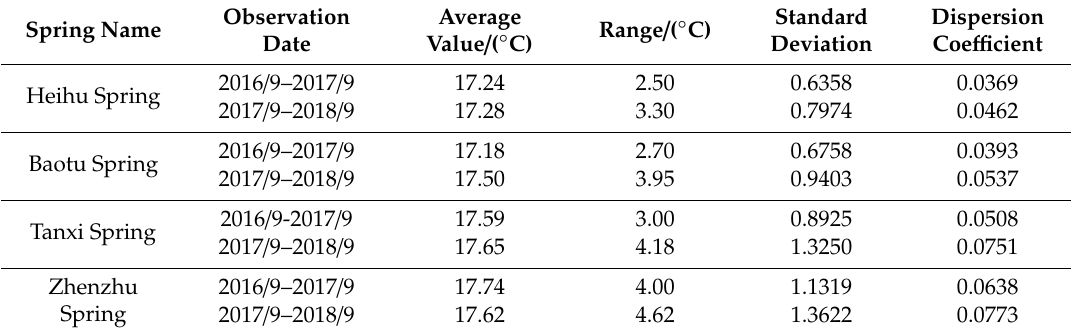
Table 2. List of characteristic values of spring water temperature